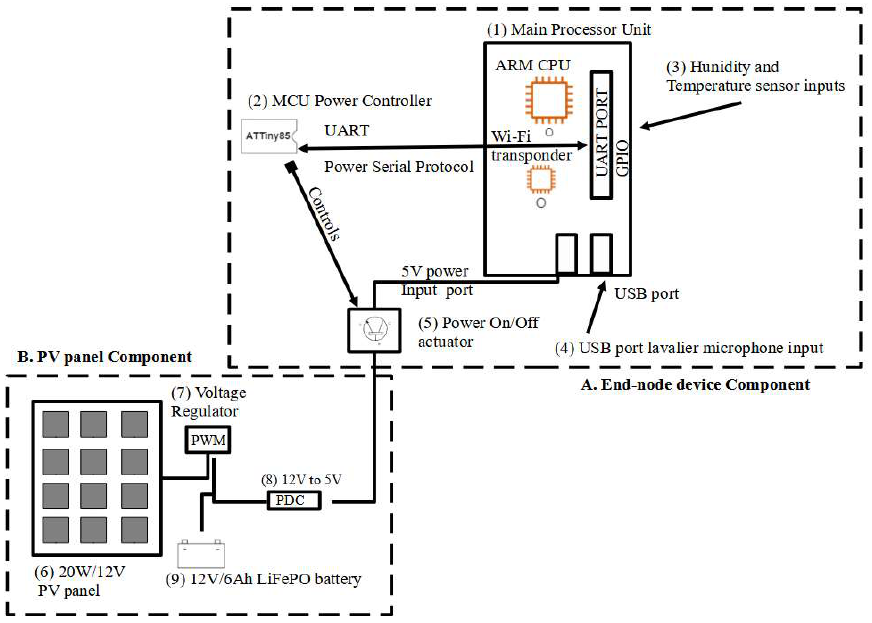
Figure 2. BeeSD end-node IoT device components and parts.